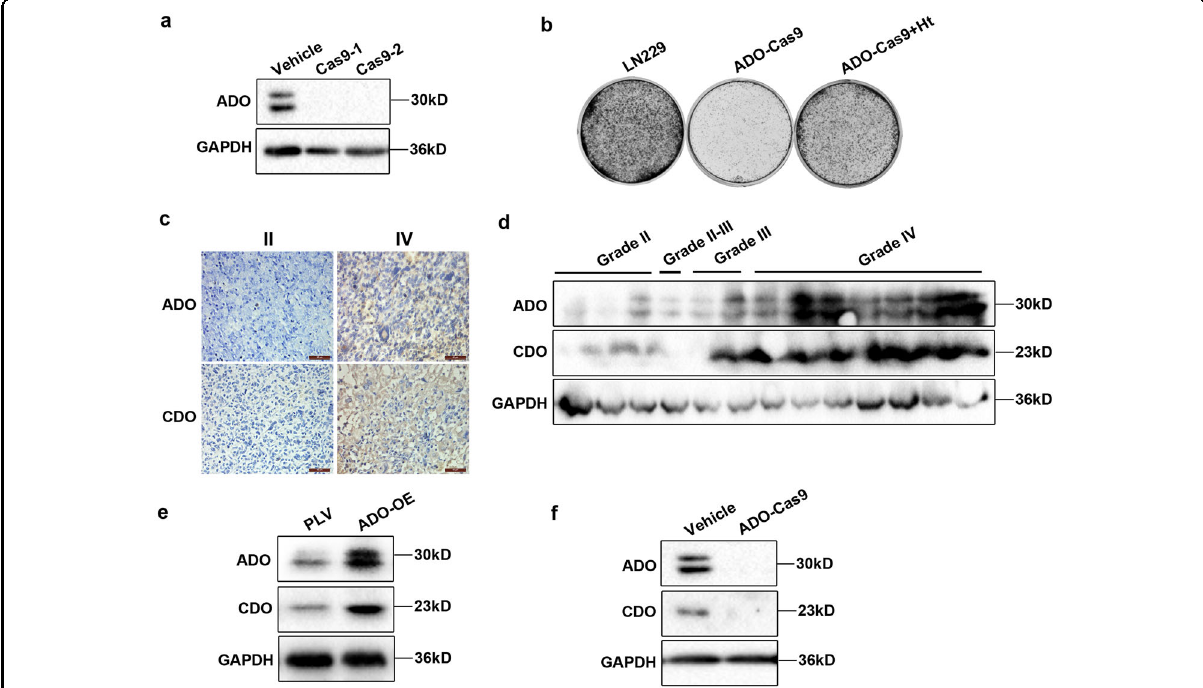
Fig. 2 ADO drives the endogenous synthesis of hypotaurine in glioma. a ADO knockout cells were generated by utilizing CRISPR-Cas9 system in LN229. b Clone formation assays were conducted to evaluate the effect of ADO-Cas9 and hypotaurine on LN229 growth. c , d Serial sections or tumor tissue lysates of one patient were used to detect ADO and CDO expression by immunohistochemistry (IHC) and western blot, respectively. Scale bars = 50 μ m. e Immunoblotting analysis of the CDO protein levels in U118 ADO-OE cells and f LN229 ADO-Cas9 cells. All results are representative of three independent